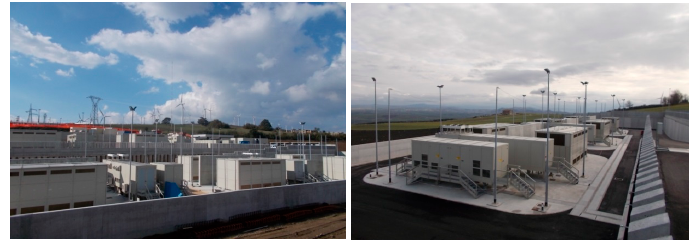
Figure 2. Some photos of Italian Na-S “energy intensive” installation in Ginestra.